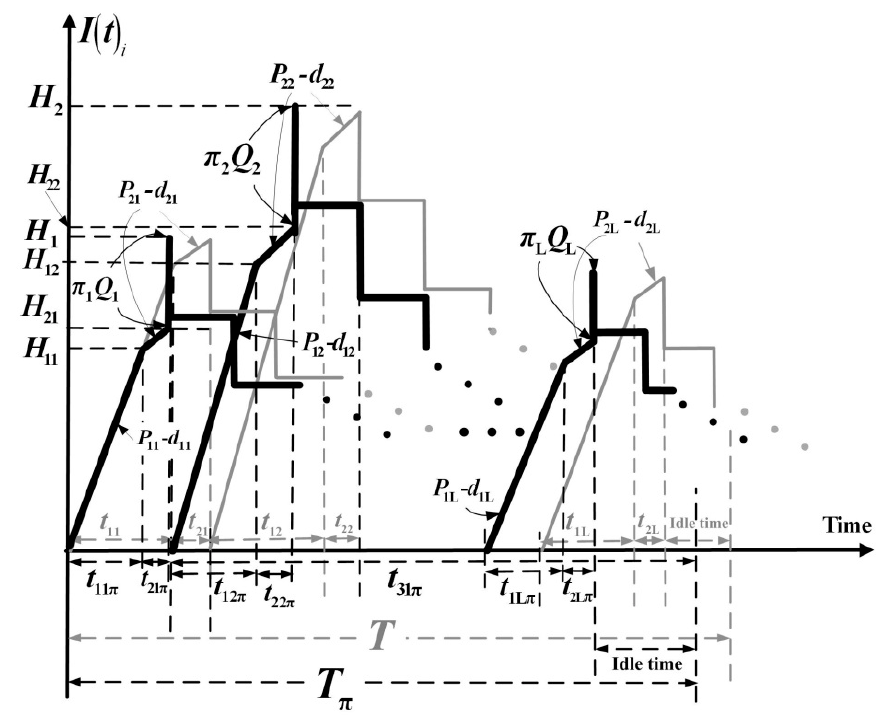
Figure 1. Inventory status of finished items at the manufacturer side of the proposed multi–item manufacturer–retailer integrated system with outsourcing and quality guarantee.